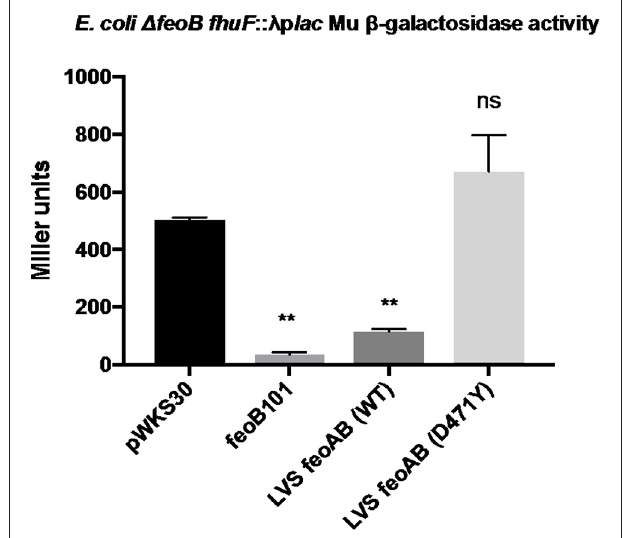
FIGURE 2 | The RML LVS feoB allele is non-functional in a heterologous iron reporter system. The coding sequence of each feoB allele was cloned into the low copy plasmid pWKS30 and introduced to E. coli H1771. The coding sequence of feoA was fused to the groE promoter in a derivative of plasmid pBB103 and supplied to E. coli H1771 in tandem with the feoB expression plasmids, and Miller assays were performed as described in the Materials and Methods. A one-way ANOVA with Dunnett’s multiple comparisons test was used to test for significance against the control pWKS30 plasmid. Significance was set at p < 0.05. **Indicates a significant difference between the labeled samples and pWKS30. Shown is a representative experiment from three